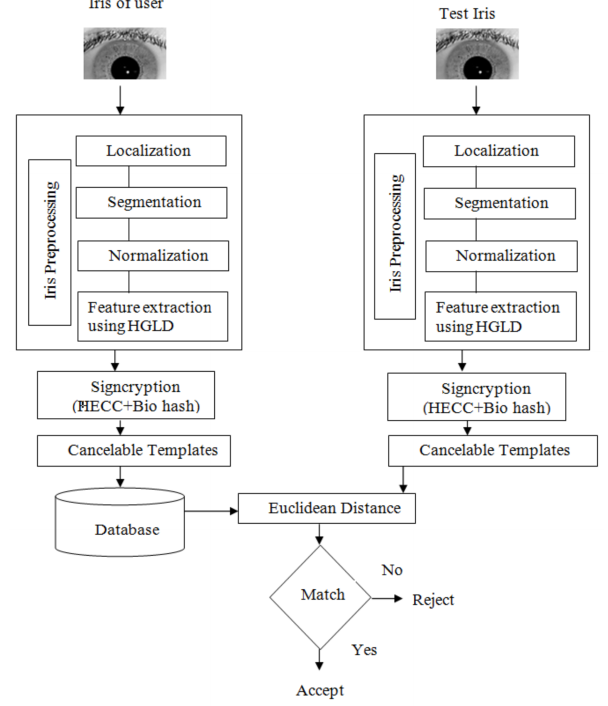
Figure 1. The flow of the proposed approach.